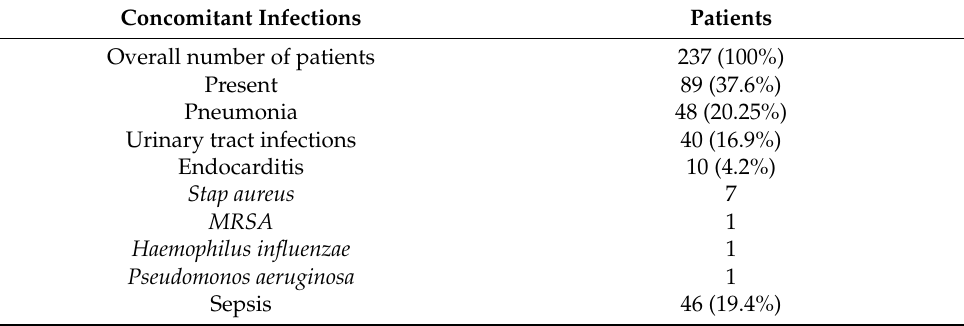
Table 5. Concomitant